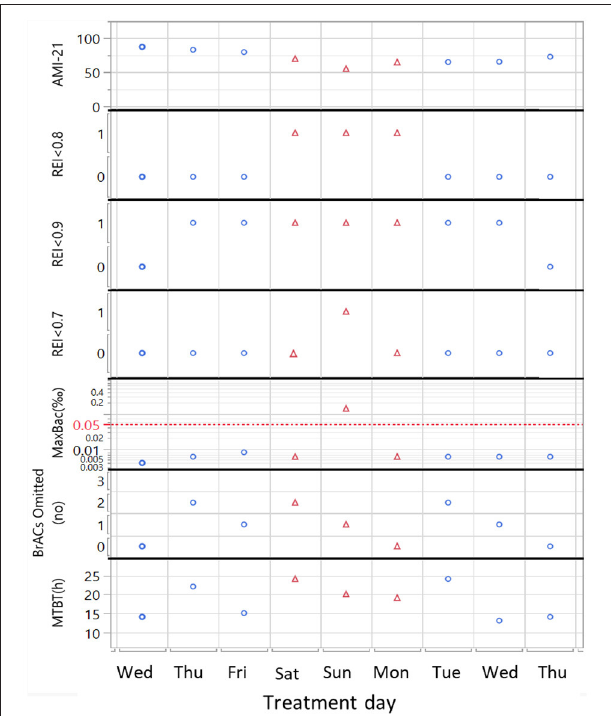
FIGURE 2 | Schematic illustration of REI threshold selection exemplified with a weekend relapse for a patient with 3 scheduled tests/day. The algorithm based on the optimal REI < 0.8 threshold identifies 3 Exacerbation Events (EE = 1, red triangles). REI < 0.9 threshold is too sensitive and identifies 7 EE’s, while the REI < 0.7 threshold identifies only 1. Only the Sunday EE is triggered by identified alcohol use (MaxBAC > 0.05 ‰ ), while the 2 other days during the same relapse are triggered by poor test compliance. X axis: treatment time in days. Y axis from top: the addiction monitoring index (AMI-21), REI in < 0.8, < 0.9 and < 0.7 bins, where 1 denotes that an EE event has occurred, highest blood alcohol content measurement that day [MaxBAC ( ‰ )], no of omitted tests (out of 3 scheduled) and maximum time between tests [MTBT (h)].